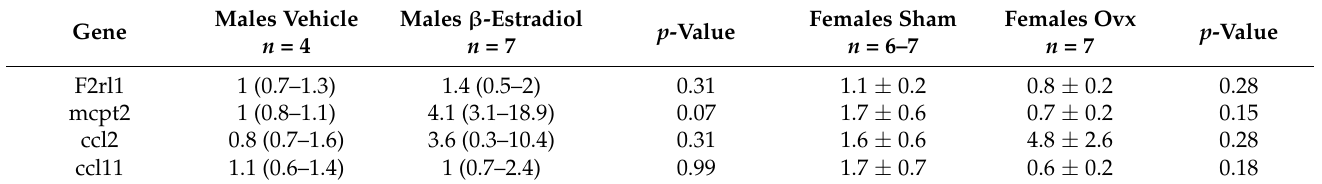
Table 2. Effect of β -estradiol on gene expression of colonic mucosal inflammatory markers.